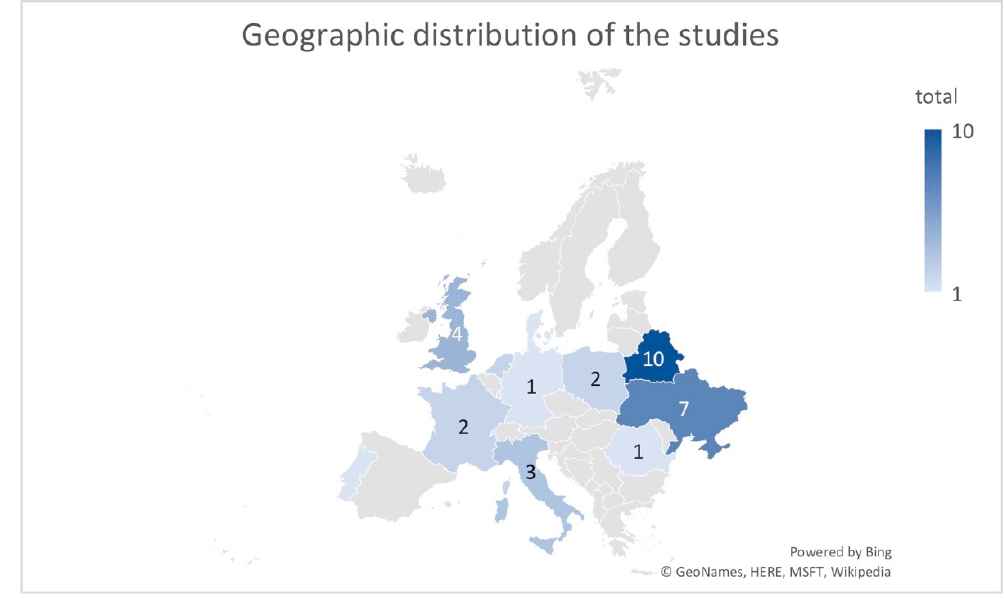
Figure 3. Geographic distribution of the studies in Europe.